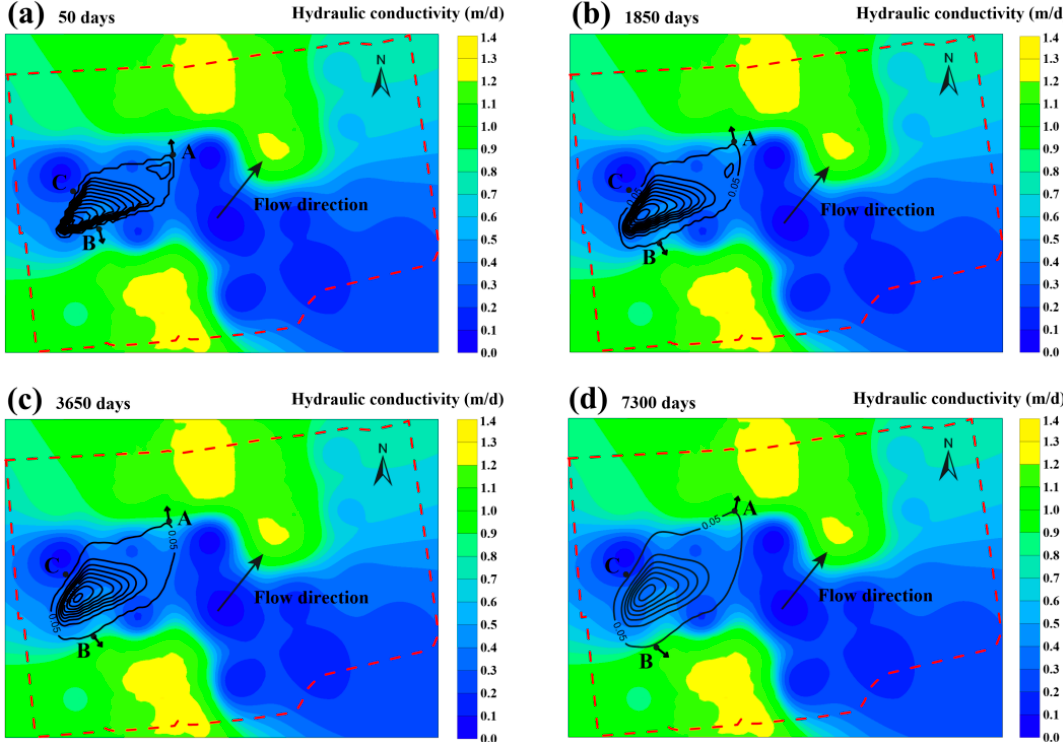
Figure 7. Simulation of pollutant concentration and prediction of concentrations at ( a ) 50 d, ( b ) 1850 d, ( c ) 3650 d, and ( d ) 7300 d, and the distribution of hydraulic conductivity in the microconfined aquifer.